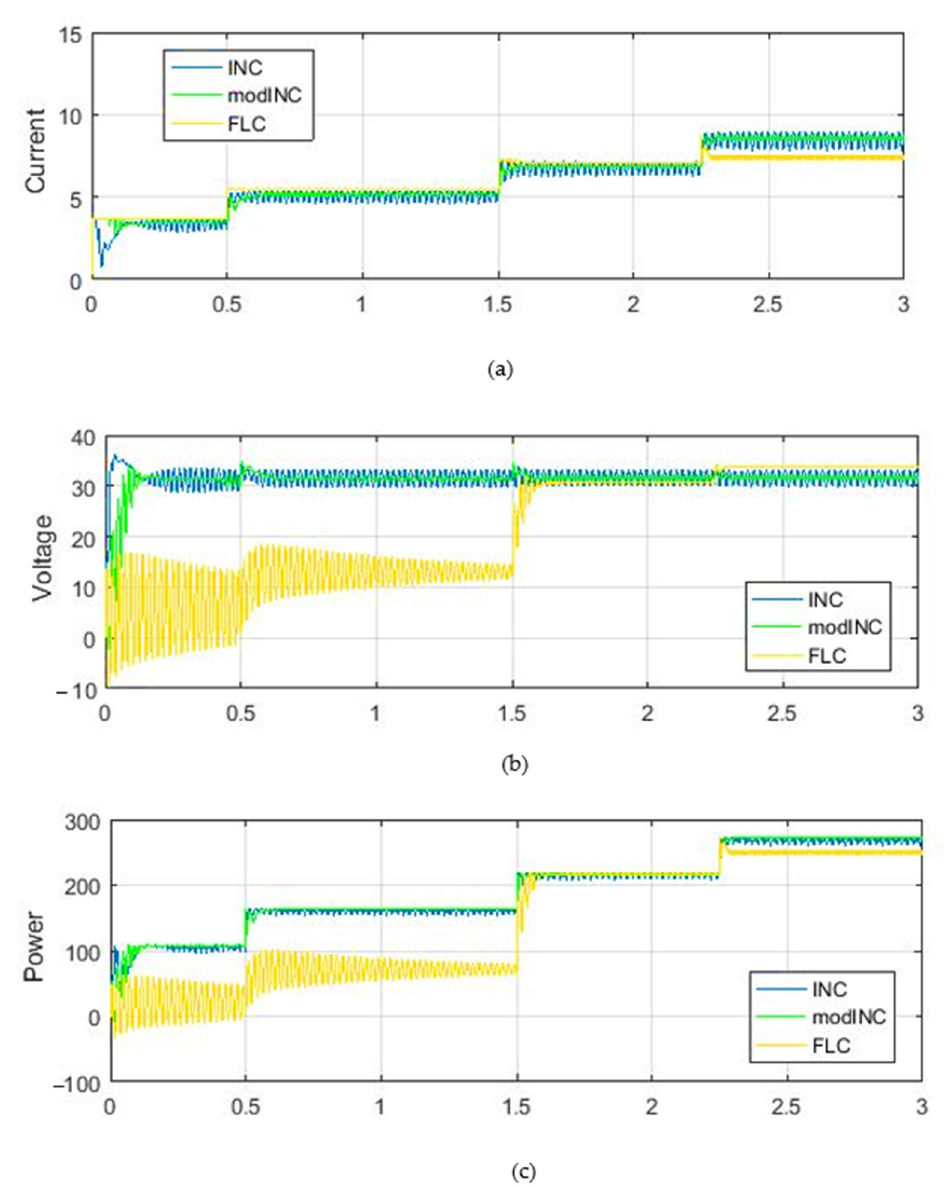
Figure 8. ( a ) Output current using INC, modINC, and FLC, by changing the irradiance. ( b ) Output voltage using INC, modINC, and FLC, by changing the irradiance. ( c ) Output power using INC, modINC, and FLC, by changing the irradiance.